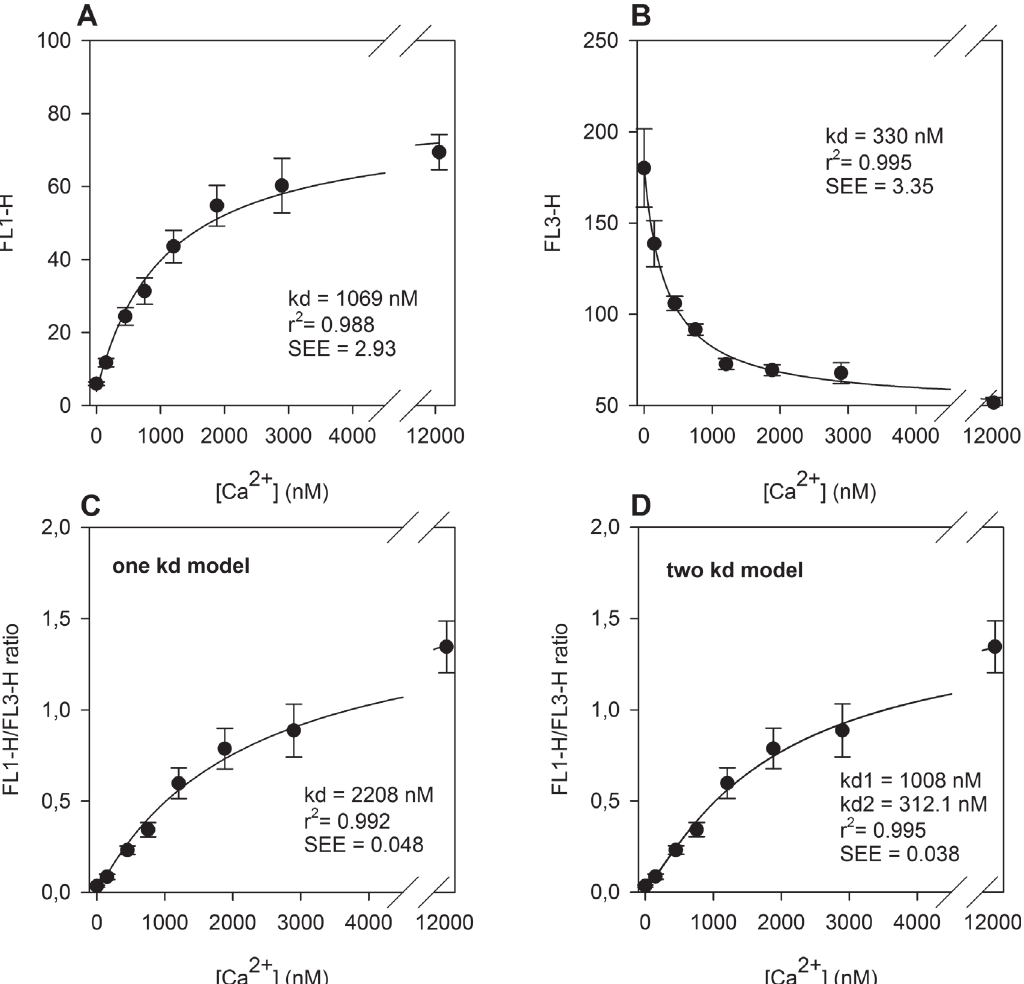
Fig 1. Determination of apparent cellular kd values for Fluo-4 and Fura Red in platelets. (A) Fitting of a single kd model (Equation 7A) to mean FL1 data of standard samples (Fluo-4). (B) Fitting of a single kd model (Equation 7B) to the mean FL3 data of standard samples (Fura Red). (C) Determination of a “ mean ” cellular kd for both dyes by fitting the “ one kd ” model (Equation 4) to the mean FL1/FL3 ratios. (D) Determination of kd values for Fluo-4 (kd Red (kd 2 ) by fitting the “ double kd model ” (Equation 9) for mean FL1/FL3 ratios. The corresponding kd, r 2 and the standard errors of esteems (SEE) are given as insets. All data are shown as means +/- S.E.M. (n =